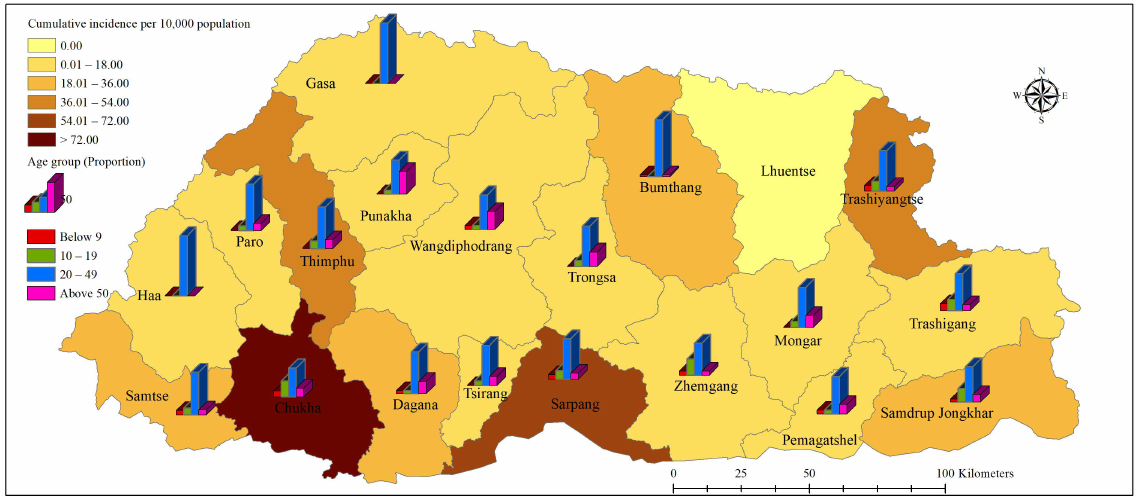
Figure 1. Distribution of cumulative incidence and proportion of cases by age groups as reported by health centers in each district during the dengue epidemic period in Bhutan, from weeks 18–49. The height of the bar corresponds to the proportionality of four age groups among dengue cases in each district.